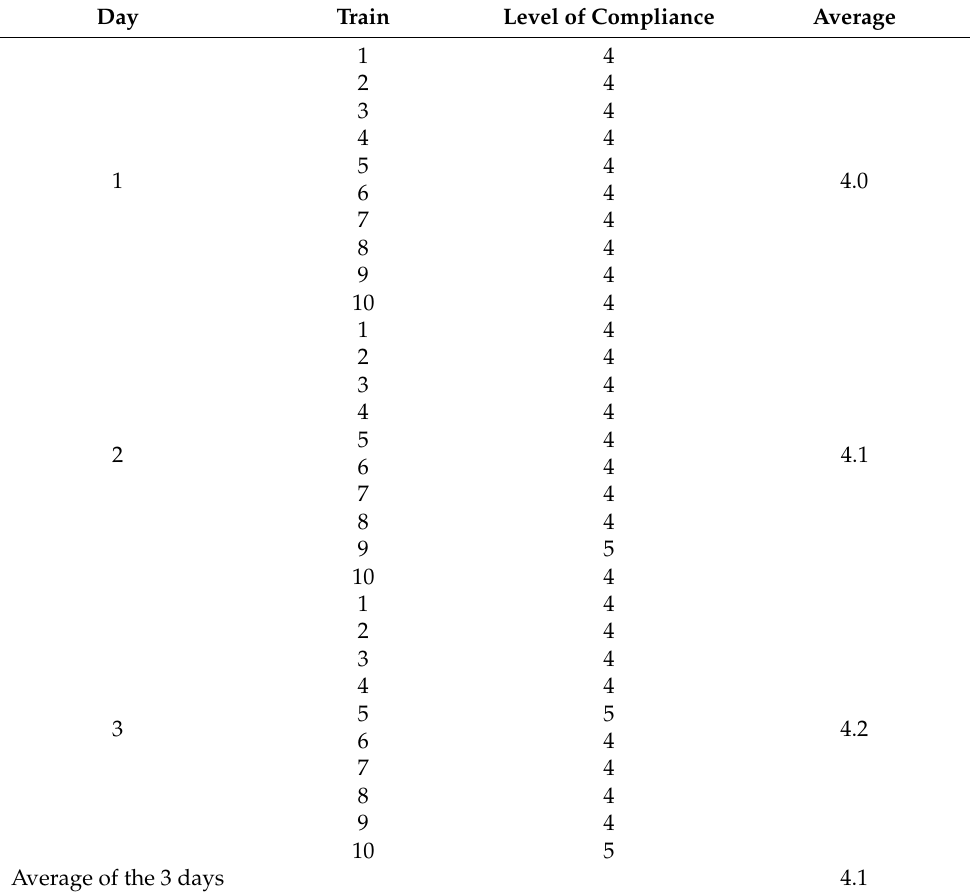
Table 5. Evaluation method of the level of compliance for the yellow safety line in Hospital Station in the Valparaiso Metro in the peak